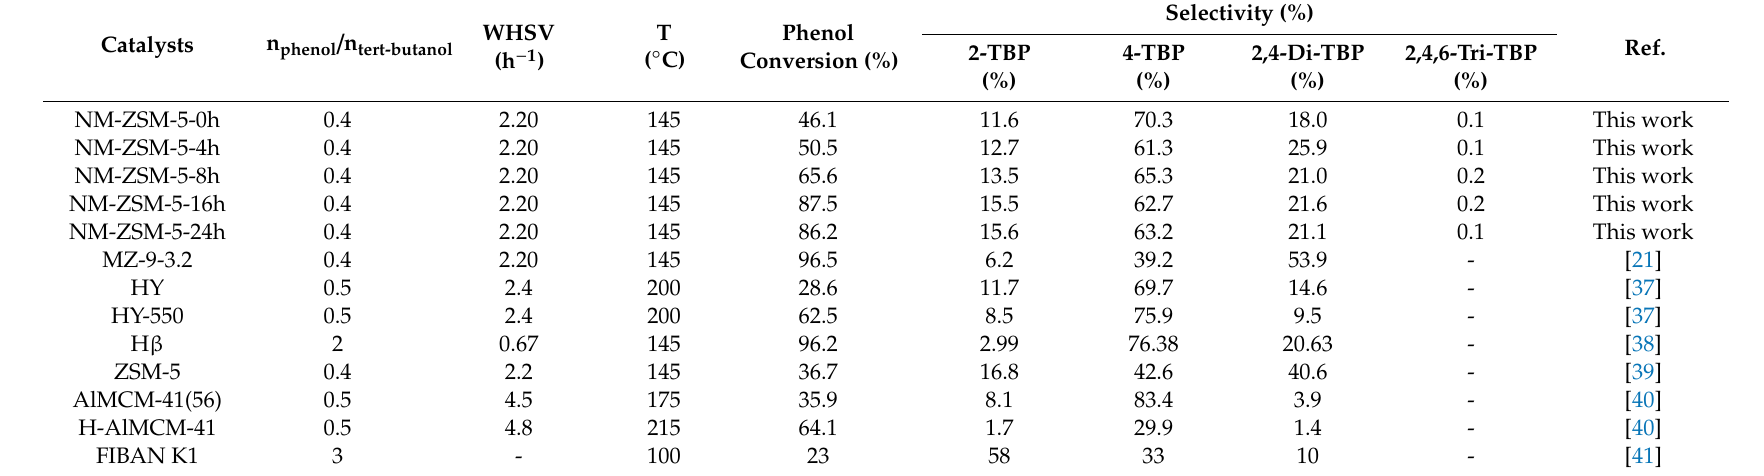
Table 1. The compared results of alkylation of phenol with tert-butanol on di ff erent